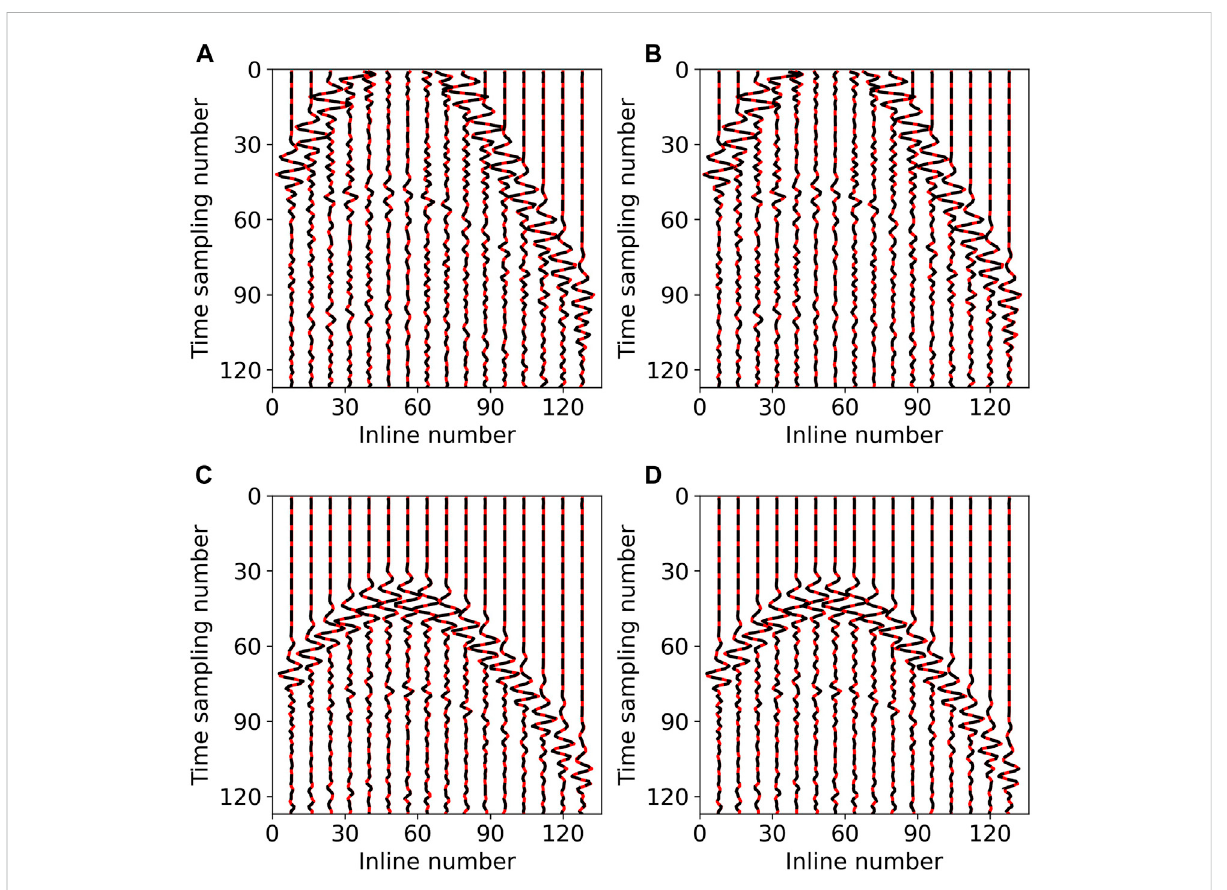
FIGURE 9 Wiggle plots on the SEG C3 synthetic data: (A) No.60 crossline slice of Unet; (B) No.60 crossline slice of DS-Unet, (C) No.110 crossline slice of Unet (Figure 8C), and (D) No.110 crossline slice of DS-Unet (Figure 8D); black dashed lines indicate reconstruction results and red solid line, ground truth.